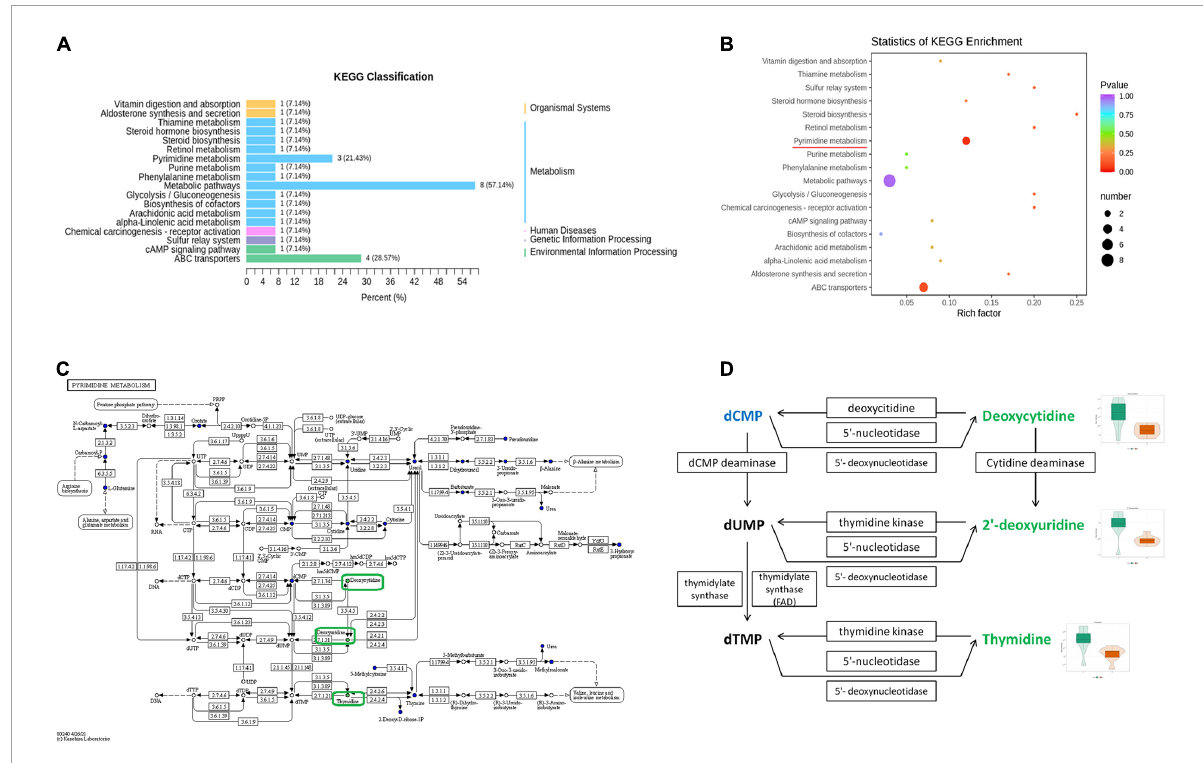
FIGURE6 Pathway analysis of differential metabolites between APP/PS1 and wild-type mice. KEGG classification between the two groups (A) and significant KEGG enrichment of differential metabolites (B) . A diagram of pyrimidine metabolism in the KEGG pathway of APP/PS1 mice (C) and a detailed view of the three differential metabolites in it (D) (red, upregulated in APP/PS1 mice; green, downregulated in APP/PS1 mice; blue, the detected metabolites with no significant change). The violin plot shows the changes in the metabolites. Groups: A, APP/PS1 double-transgenic mice; C, wild-type control group of C57BL/6J mice; n = 8/group.